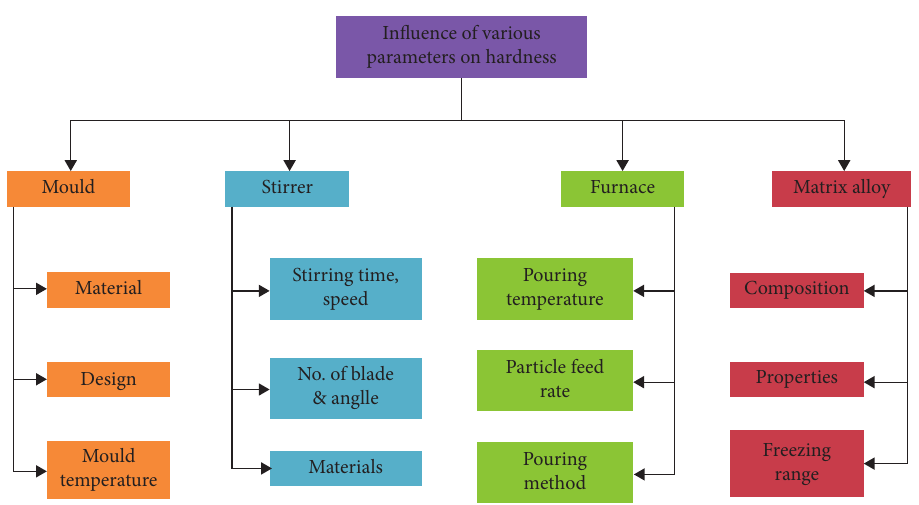
Figure 5: Classification of fabrication method of AMCs.